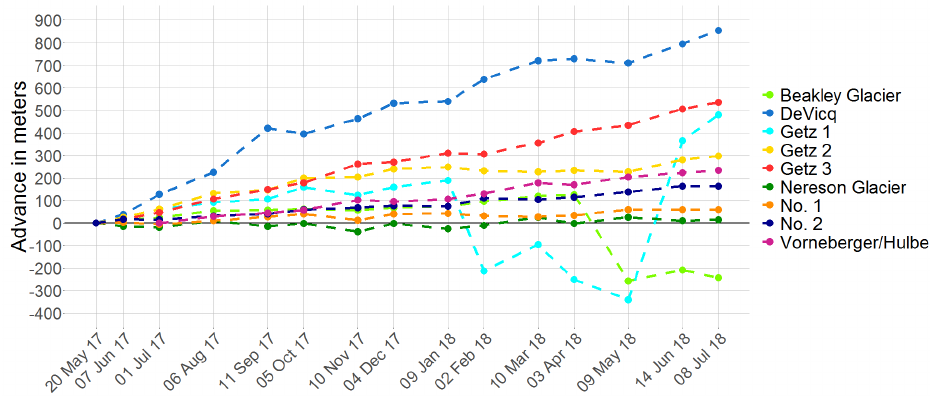
Figure 7. Calving front fluctuations in meters along the Getz Ice Shelf relative to May 2017. The advance / retreat is calculated as the median of all transect measurements along each front. Positive values indicate calving front advance, negative values retreat. Table 5 Glacier change rates per year with mean standard deviation from Table 4 and R-square of the linear regression.